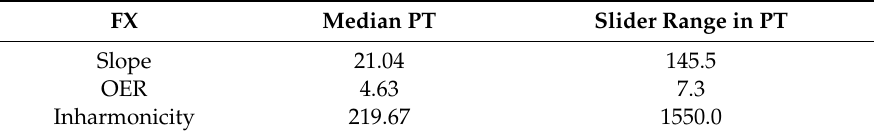
Table 4. Median slider setting in units of PT (Perception Threshold). In the special bi-modal case of OER (odd / even ratio), the median PT values for the slider range 0.0–0.5 and 0.5–1.0 are 2.05 and 5.91, respectively. FX = timbre